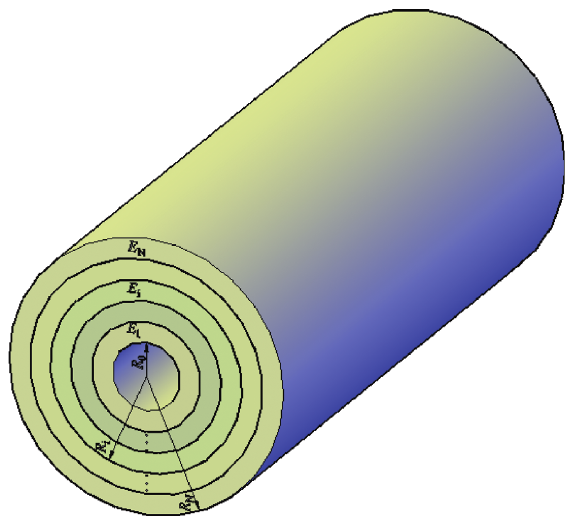
Figure 1: Functional graded lining (FGL)